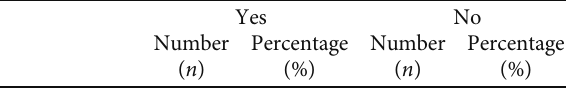
Table 4: Status of thinking that COVID-19 vaccines have serious side e ff ects according to some features of the participants, Kastamonu,